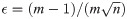
Fan.(A) The Fan Fn,m (or Windmill [56]) consists of one hub and n blades containing m vertices each. We consider a weighted version, with edge weights as shown. Pictured here is the case n = m = 3. (B,C) The neutral fixation probability ρ∘ and weak selection coefficient ρ′, plotted as ϵ varies from 0 to infinity, for all Fan graphs of sizes N = 13 and N = 101. As ϵ increases, the behavior changes from absolute and relative suppressor, to absolute and relative amplifier, to relative amplifier but absolute suppressor. For ϵ → ∞, the ρ∘ and ρ′ values approach those of the Star graph Snm (marked by a red star). (D) As n → ∞, there are three regimes of behavior, depending whether ϵ is held constant (blue line) or scales as n−1 (purple line), or as n−2 (green line). The maximal ρ′ for fixed m is ρ′ = (m + 1)/(2m), achieved for n → ∞ with ϵ=(m-1)/(mn).